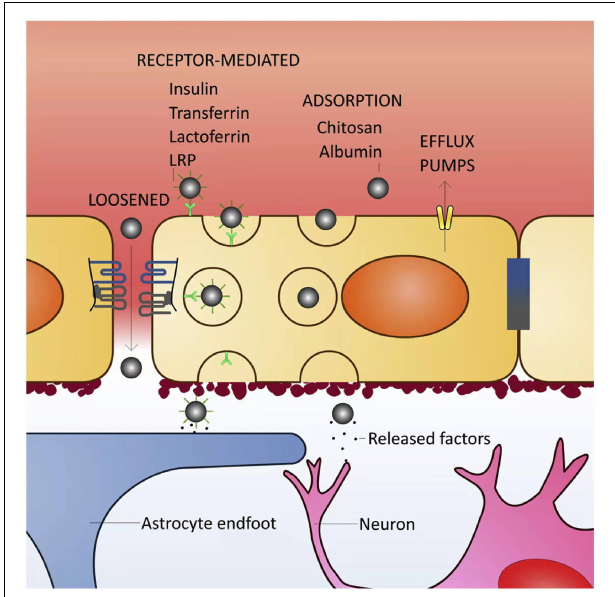
FIGURE 2 | Blood–brain barrier (BBB) transport mechanisms for brain delivery of nanoparticles (NPs). The BBB is highly selective and has specific transport mechanisms allowing a close control of molecules/cells that enter the brain parenchyma. Loosened tight junctions (TJs) allow the cross of NPs through the BBB, either by the presence of a surfactant in NPs able to disrupt the TJs or by BBB impairment due to pathological conditions. Receptor-mediated transcytosis is the most common type of transport for NP entry into the brain. NPs can be functionalized with different types of ligands (such as insulin, transferrin, lactoferrin or antibodies against some endothelial receptors), or surfactants like polysorbate 80 [that adsorbs plasma proteins, namely apolipoprotein E enabling their binding to the lipoprotein receptor-related proteins (LRPs)]. The interaction between NP ligands and respective receptors in the endothelial cell (luminal side) surface triggers plasma membrane invaginations followed by pinch free forming vesicles, which facilitates the release of the NPs in the opposite site of the membrane (parenchymal side). NPs coated with molecules such as albumin or chitosan can cross the BBB by adsorptive transcytosis. Efflux pumps may reduce the amount of NPs retained in brain parenchyma (Saraiva et al.,